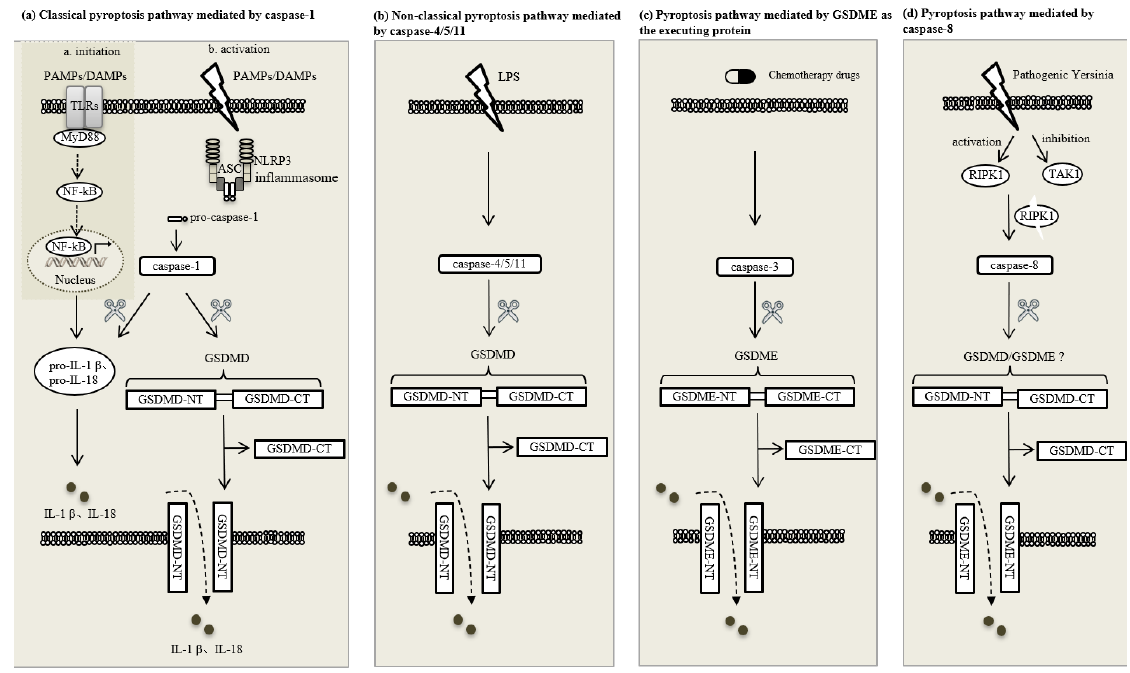
Figure 1. Pathways of pyroptosis. ( a ) Classical pyroptosis pathway mediated by caspase-1; ( b ) nonclassical pyroptosis pathway mediated by caspase-4/5/11; ( c ) pyroptosis pathway mediated by GSDME as the executing protein; ( d ) pyroptosis pathway mediated by caspase-8. The classical pyroptosis pathway involves two steps: initiation and activation. TLRs are Toll-Like Receptors. MyD88 is myeloid differentiation factor 88. NF- κ B is nuclear factor-kappa B. PAMPs are pathogen-associated molecular patterns. DAMPs are damage-associated molecular patterns. ASC is speck-like protein containing a CARD. Caspase is cysteinyl aspartate-specific proteinase. GSDMD is Gasdermin D. IL-1 β is interleukin-1 β . IL-18 is interleukin-18. LPS is lipopolysaccharide. GSDME is Gasdermin E. RIPK1 is receptor-interacting protein kinase 1. TAK1 is transforming growth factor β -activated kinase